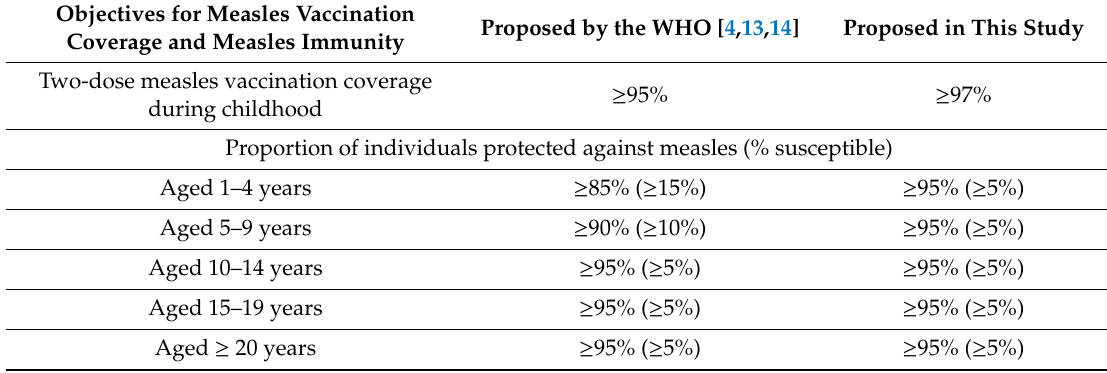
Table 1. Objectives for two-dose measles vaccination coverage during childhood and for the proportion of protected individuals in di ff erent age groups proposed by the World Health Organization (WHO) and the objectives proposed in this